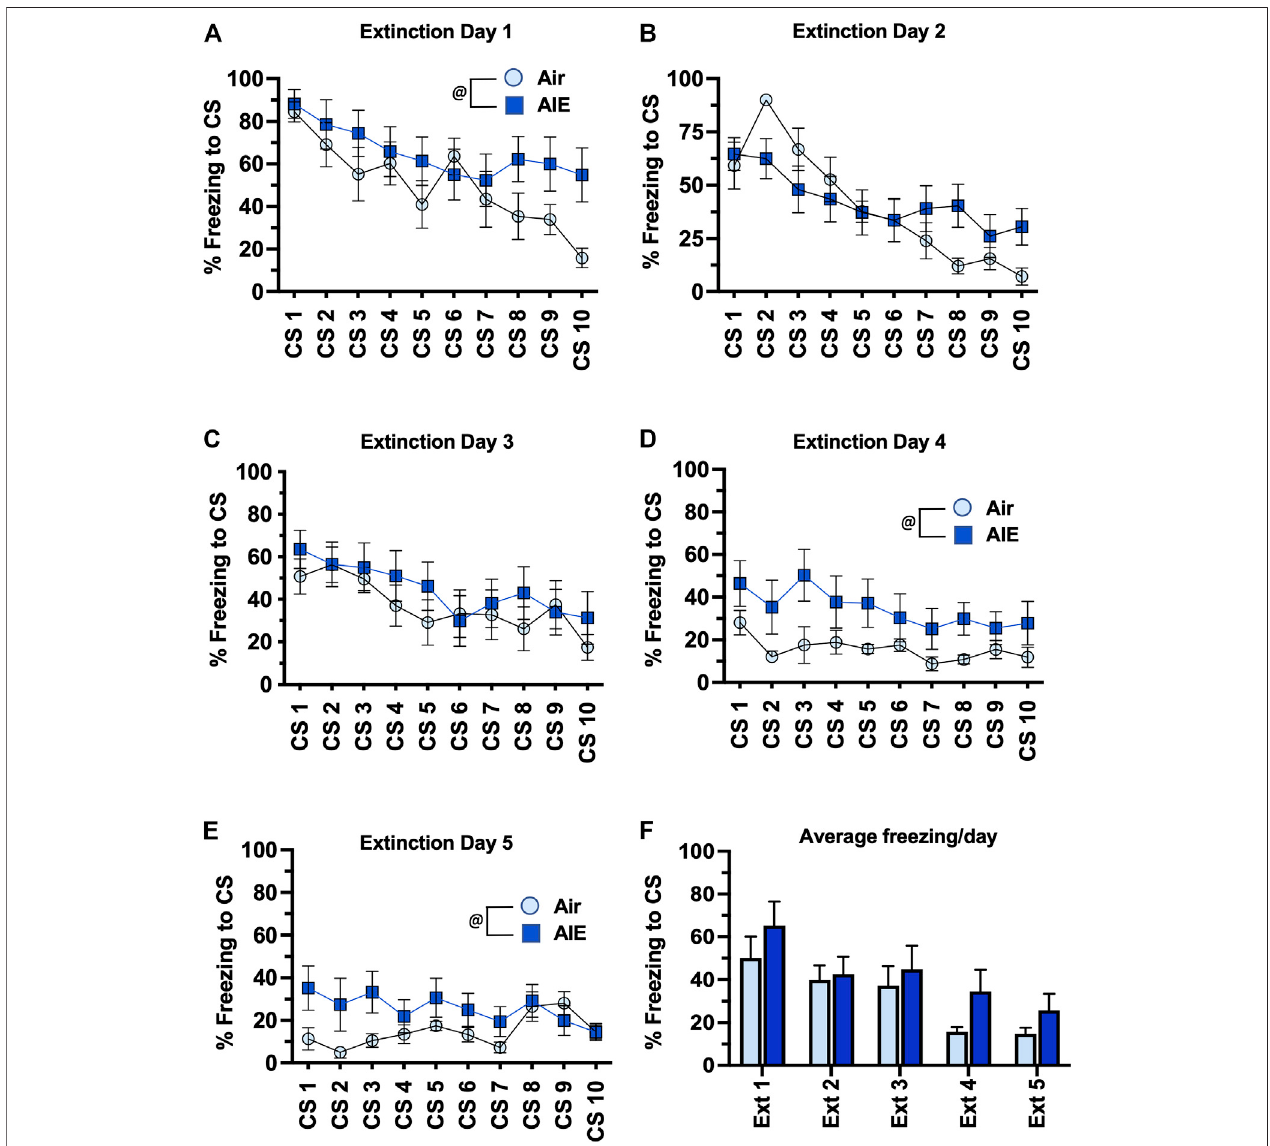
FIGURE 7 | AIE exposure did not alter extinction of conditioned fear in high conditioning (HC) female rats. (A – E) Five consecutive days of presentation of the CS (tone) without theshock (10/session/day) resultedin aday and session-dependentreduction offreezingto presentation ofthetone.While AIE exposure wasassociated with small but statistically signi fi cant alterations freezing on several of the days of extinction, analysis of the average freezing across the 10 tones for each daily extinction session (F) indicated there were no signi fi cant differences between the Air control and AIE exposed rats at any ofthe 5 extinction days. @, signi fi cant main effect of AIE exposure (all p values < 0.01). Air, n = 6; AIE, n = 9.